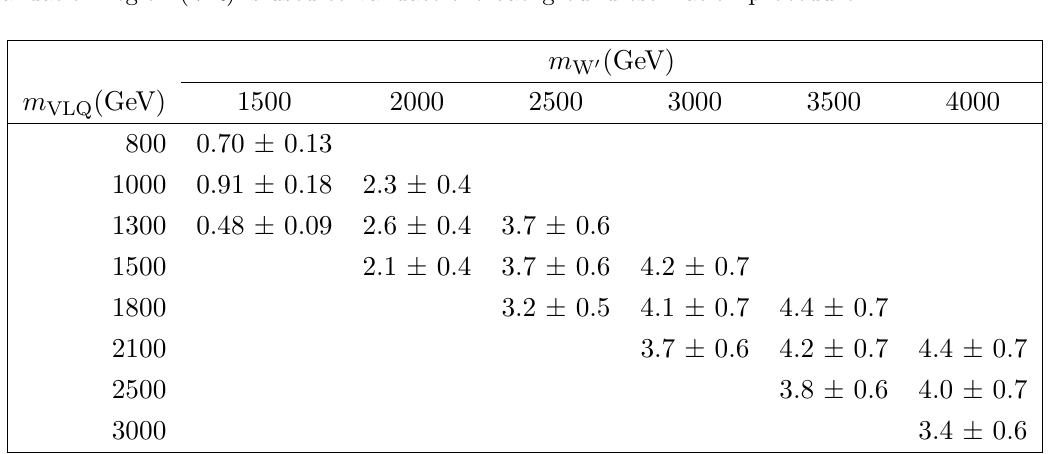
Table 1 . Selection regions used in the analysis. Tagging discriminator selections and regions described in the text are explicitly de(cid:12)ned here. The signal region (SR) is used to set cross sec- tion upper limits, the control regions (CRN) are used to estimate the QCD background, and the validation region (VR) is used to validate the background estimation procedure.